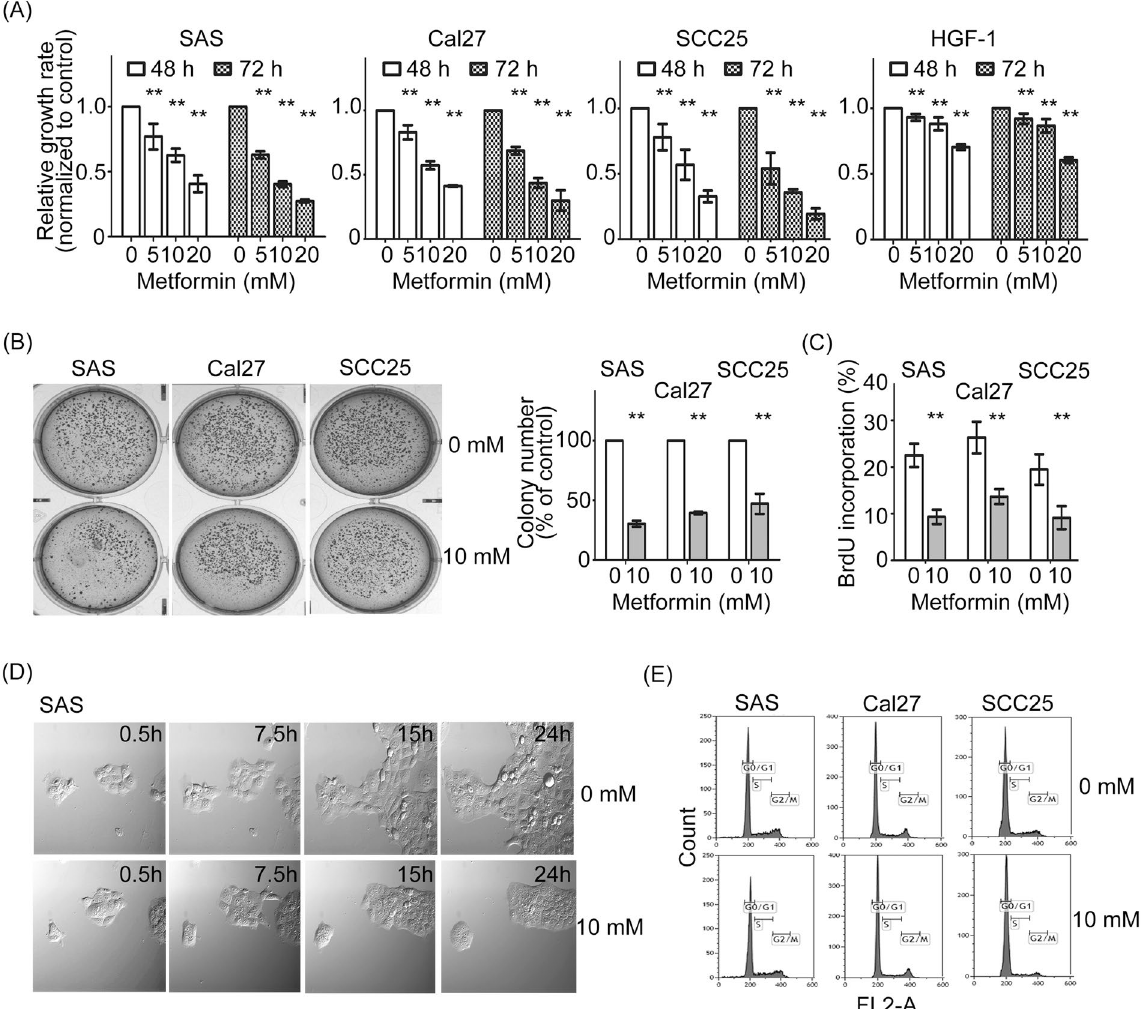
Figure 1. Treatment with metformin reduces the viability of oral cancer cells. ( A ) Proliferation assays performed with SAS, Cal27, SCC25, and HGF-1 cells show cell viability in the presence of metformin. ( B ) The effect of metformin on colony formation in SAS, Cal27, and SCC25 cells. Representative images and colony numbers were shown. ( C ) Forty-eight hours later, cells were subjected to BrdU incorporation assays. ( D ) Effect of metformin on progression in SAS cells. Asynchronously SAS cells were treated with 10 mM metformin and then subjected to in vivo time-lapse microscopy. ( E ) After treatment with metformin (10 mM) for 48 h, SAS, Cal27, and SCC25 cells were examined using PI staining. The cell cycle distribution was measured by flow cytometry. Data are represented as mean ± SD of three individual experiments. ( ** p <